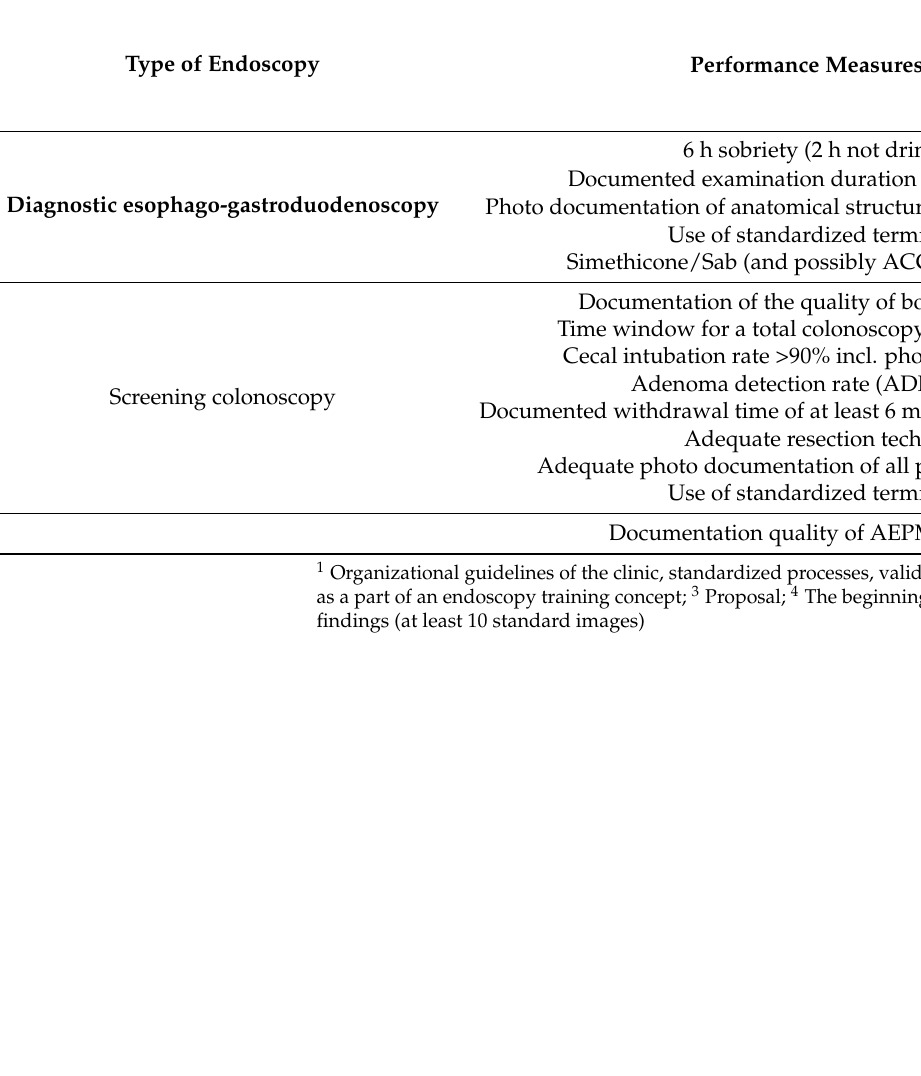
Table 7. Performance measures, assessment and